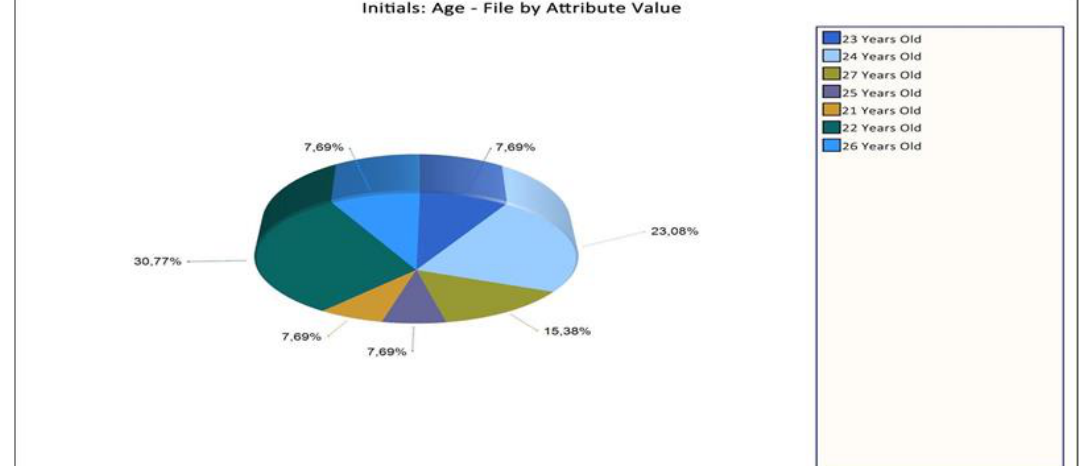
Fig. 1 . Distribution of participants by